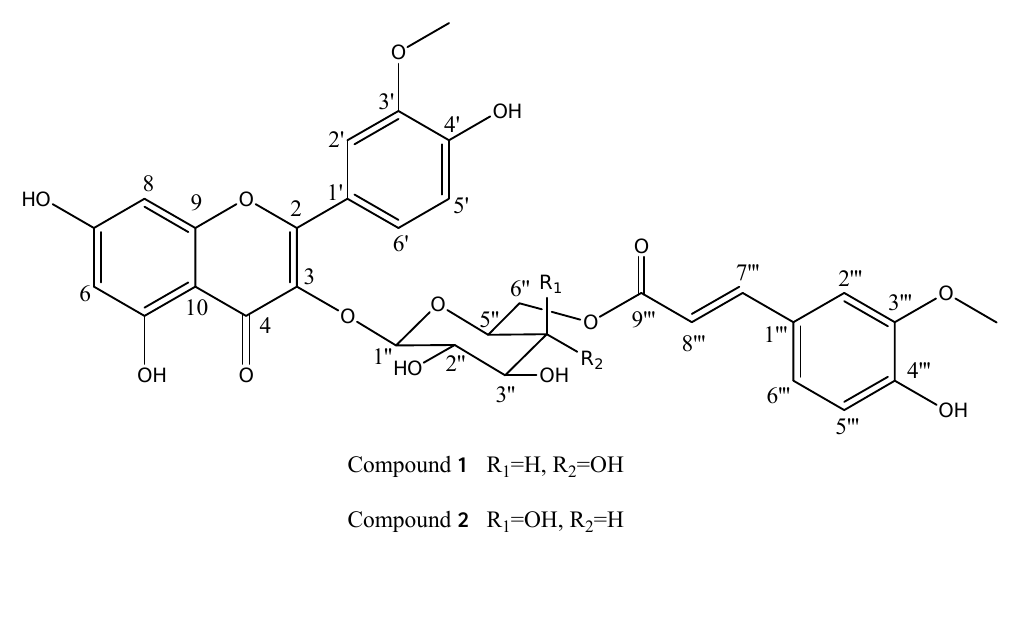
Figure 1. The structures of new compounds 1 and 2